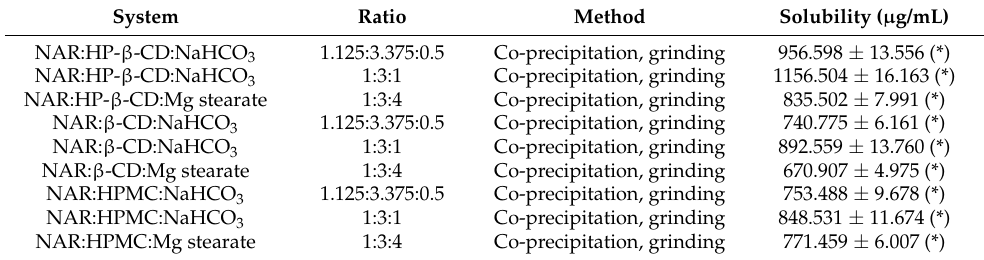
Table 1. Solubility of NAR in ternary solid dispersions. (*) indicates statistically significant differences, p <